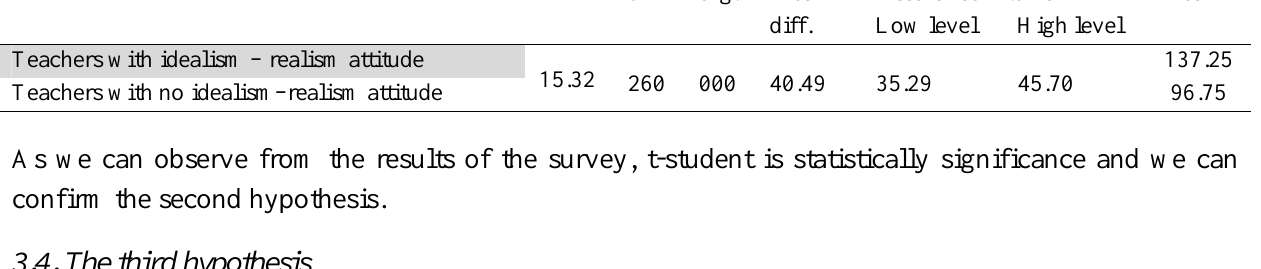
T-test of two independent groups for testing the second hypothesis Teachers with idealism – realism attitude